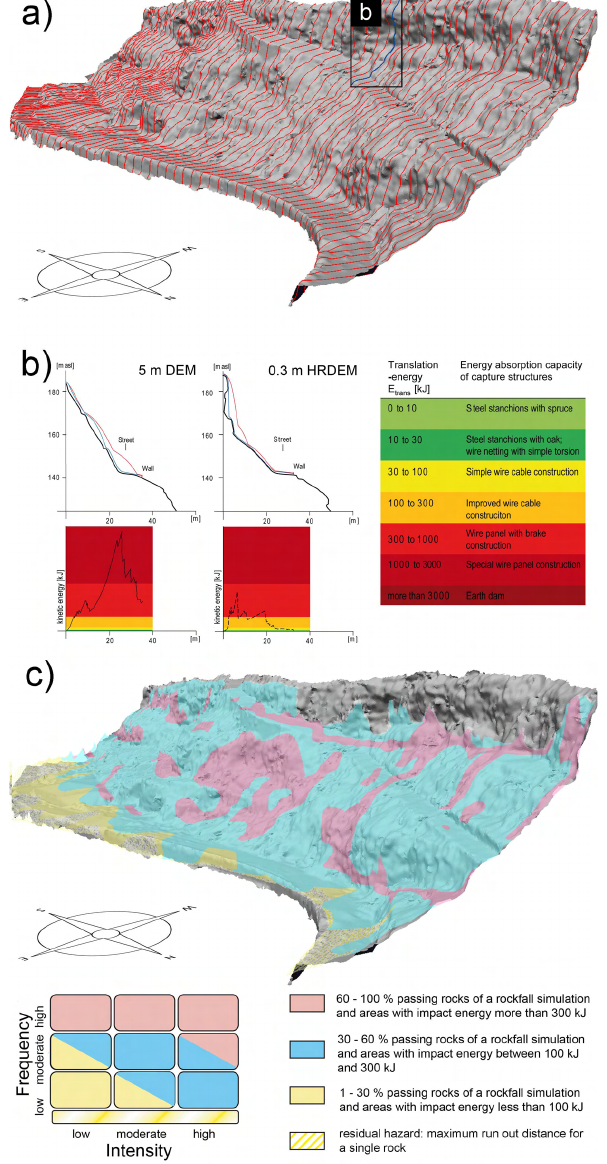
Fig. 9. Automatically created cross-sections (red lines) on a HRDEM are used to perform rockfall simulations along the slope at frequent intervals (a) . Comparison of numerical simulation of profiles at the same location, using DEM and HRDEM data with identical input parameters (b) . Classifying the simulation results, a zoning by impact frequency and energy, is possible (c) .